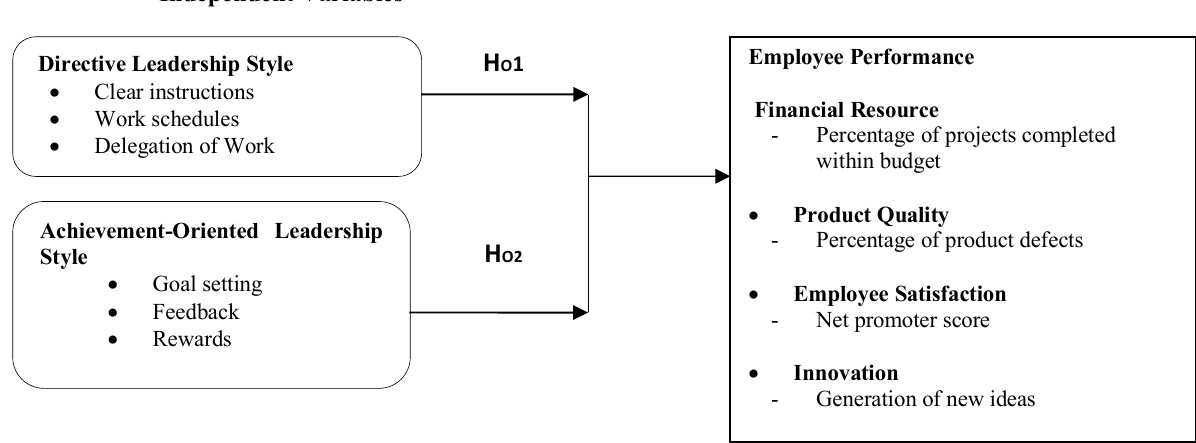
Figure 1: Conceptual